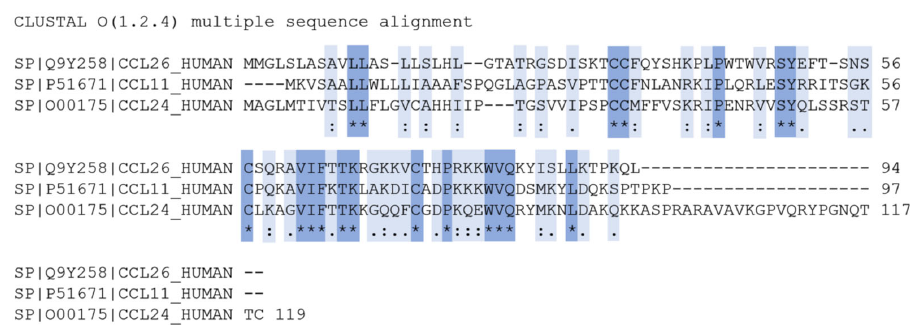
Figure 1. Sequences homology of eotaxins CCL11 and CCL24 to CCL26; “*” (asterisk): Positions with a single, fully conserved residue; “:” (colon): Conservation between groups of strongly similar properties (scoring > 0.5 in the Gonnet PAM 250 matrix); “.” (period): Conservation between groups of weakly similar properties (scoring ≤ 0.5 in the Gonnet PAM 250